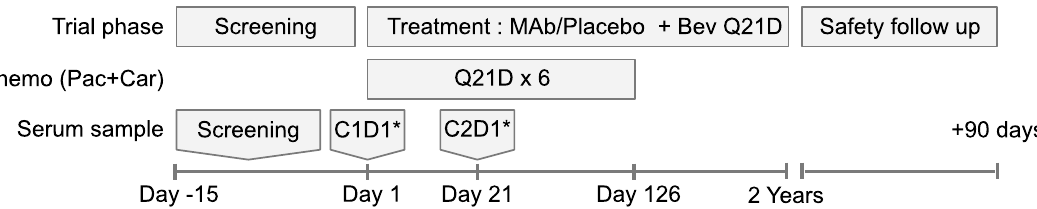
Figure 1. Outline of trial design. Bev: Bevacizumab; Car: Carboplatin; Pac: Paclitaxel, MAb: Experimental antibody; C1D1: Cycle 1 day 1; C2D1: Cycle 2 day 1; Q21D: Dose administered every 21 days; * Sample collected prior to dosing.